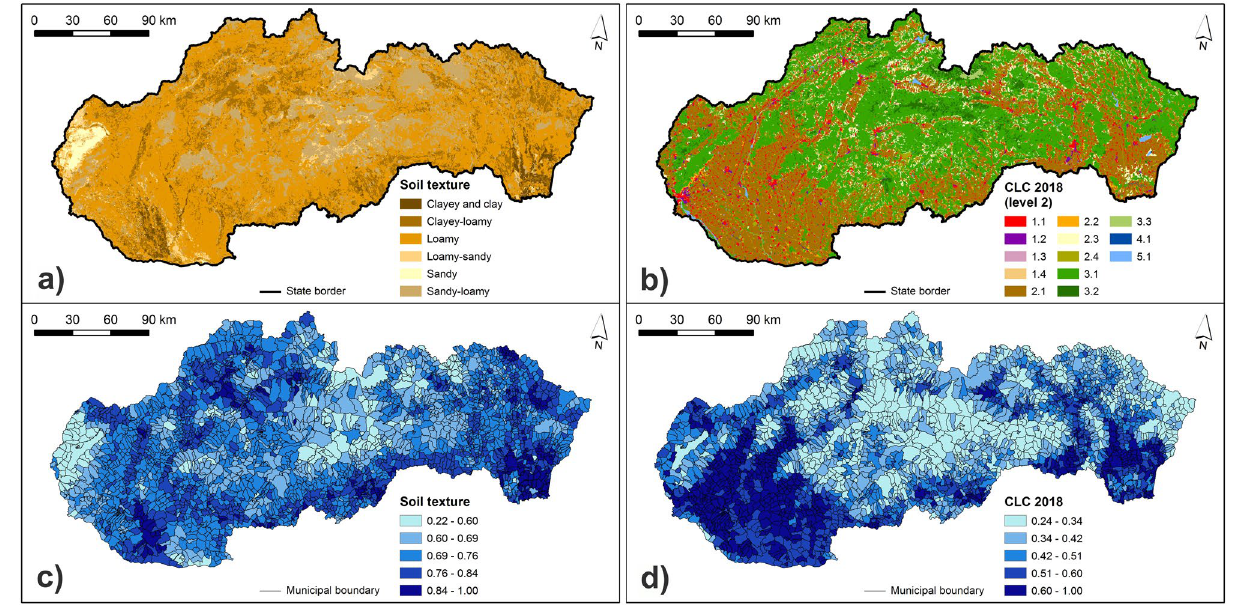
Figure 6. Soil texture and land cover indicators: ( a ) original soil texture values; ( b ) original land cover values; ( c ) normalized soil texture values; ( d ) normalized land cover values. This figure was generated in ArcGIS 10.2.2 software.